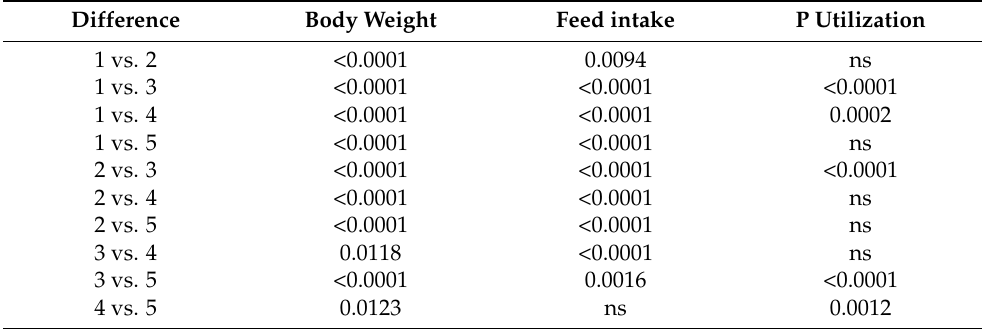
Table A2. p -values of pairwise comparisons of body weight, feed intake and phosphorus utilization between periods independent of the haplotype. Tukey post hoc was used for testing.